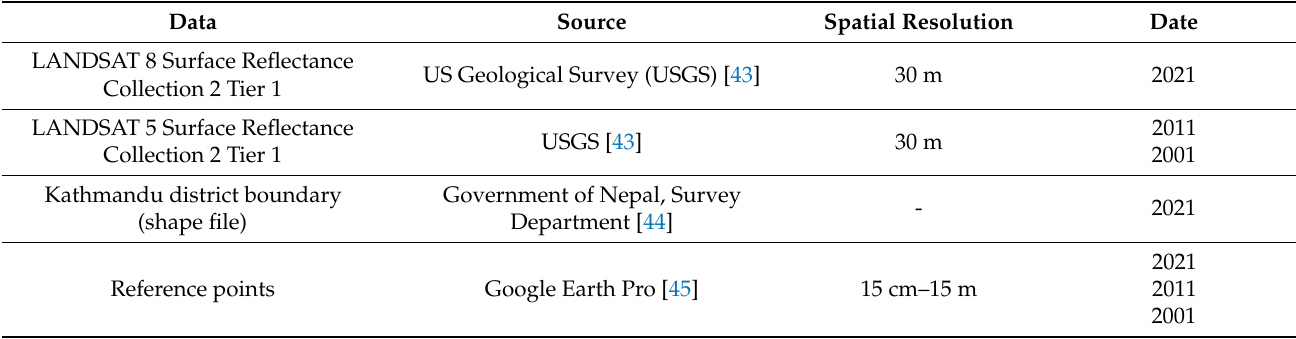
Table 1. Data used for land-cover analysis.